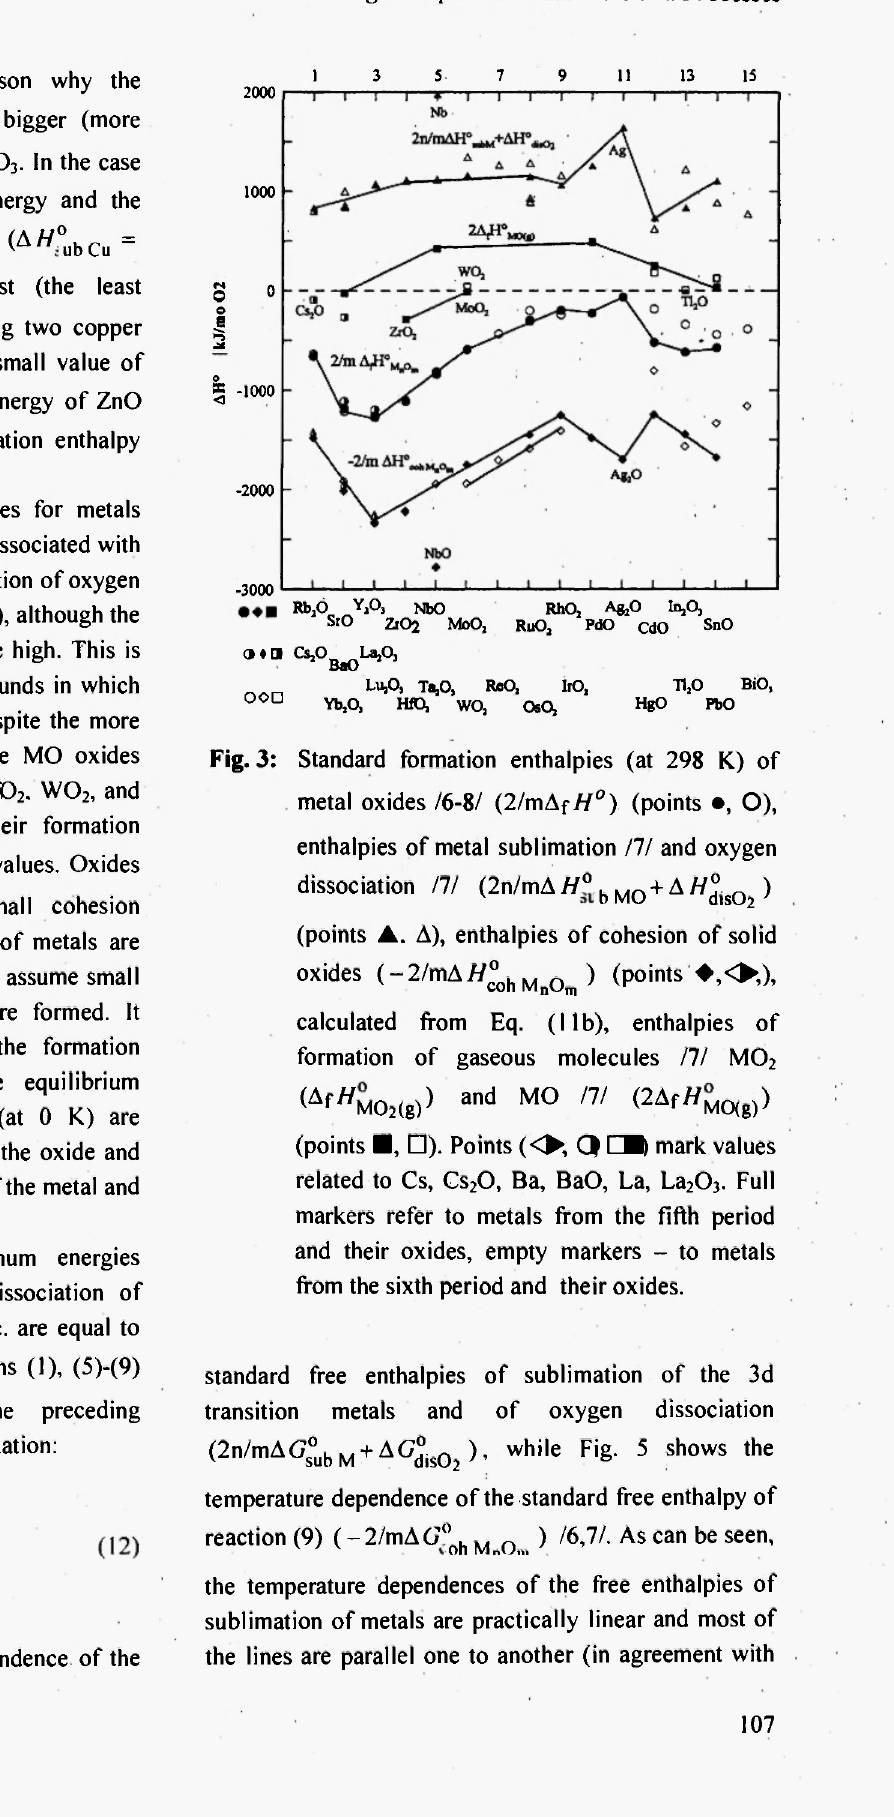
Fig. 3: Standard formation enthalpies (at 298 Κ) of metal oxides /6-8/ (2/mAf//°) (points ·, O), enthalpies of metal sublimation 111 and oxygen